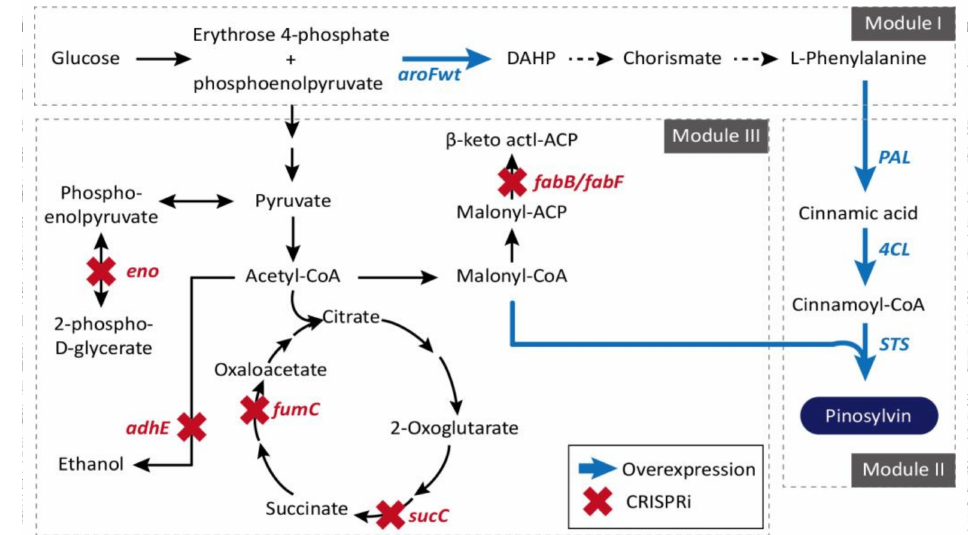
Figure 5. For high-yield pinosylvin synthesis, three different modules are selected and redirected. Genes selected for efficient channeling of the carbon flux toward malonyl-CoA, shown in red, are inhibited through CRISPRi. The metabolic pathway that performs heterologous biosynthesis of (2S)-naringenin from L-tyrosine in E. coli shown in blue was overexpressed. CHI: chalcone isomerase; CHS: chalcone synthase; 4CL: 4-coumarate:CoA ligase; E4P: erythrose-4-phosphate; PEP: phosphoenolpyruvate; TAL: tyrosine ammonia lyase